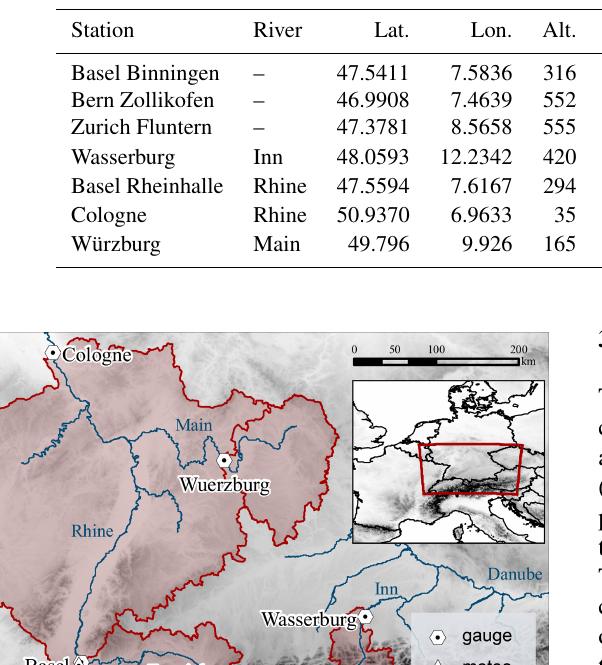
Table 1. Database studied: station name, associated river, location (WSG 84), altitude (m), daily resolution time series investigated with temperature ( T ), precipitation ( P ) and discharge ( D ), catchment area, mean runoff (MQ) and data source with the Global Runoff Data Centre (GRDC) and Federal Office of Meteorology and Climatology of Switzerland (MeteoSwiss).